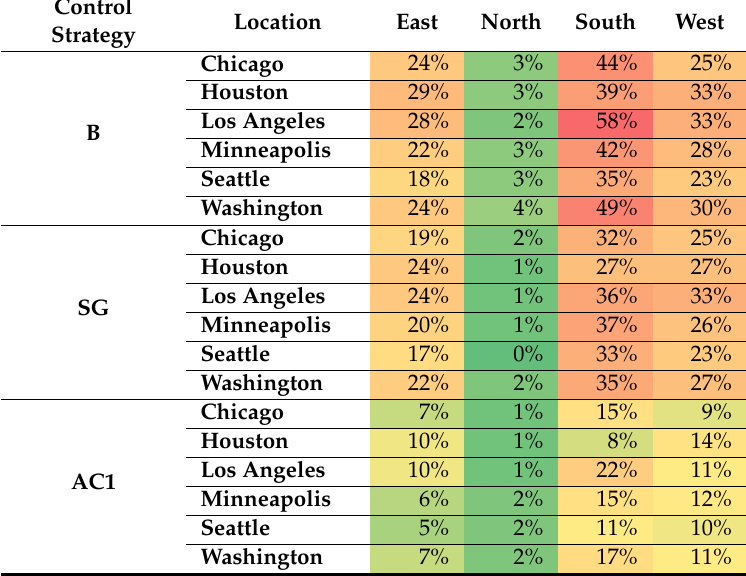
Table 3. Results for glare showing percentage of time DGP is > 0.4 for di ff erent locations, control strategies, and window orientations. (Color diverges from red to green as the glare changes from higher value to lower